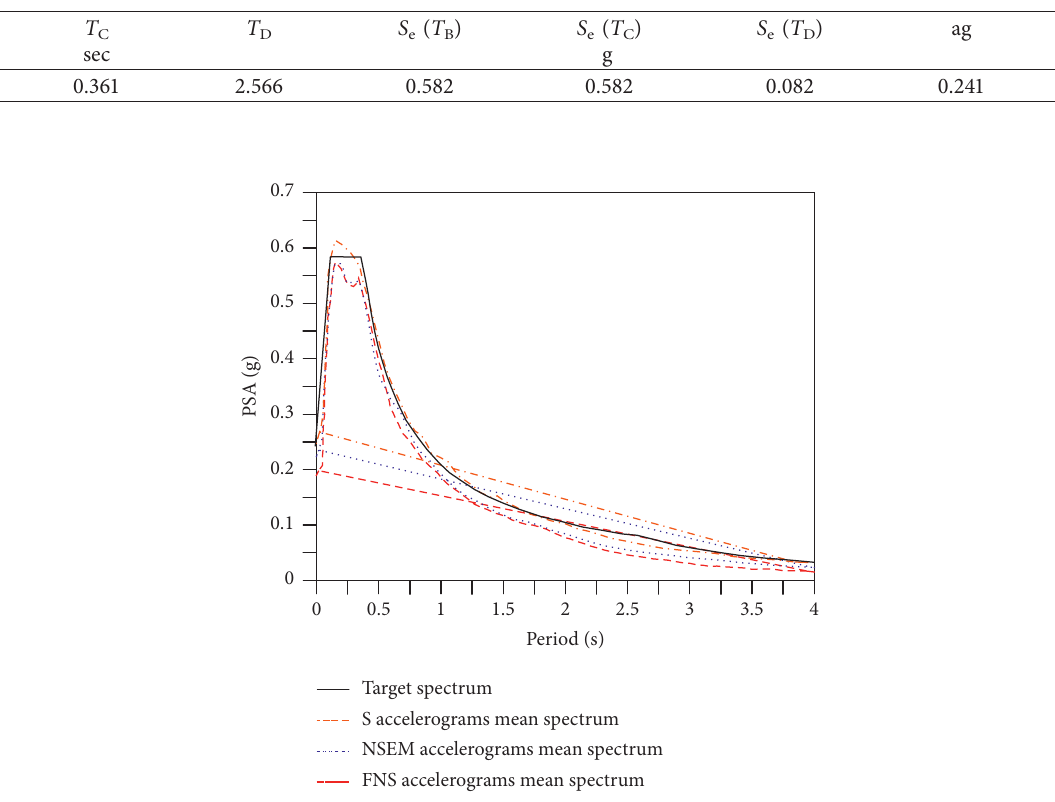
Figure 1: Target spectrum and mean spectra obtained from the 3 sets of seismic